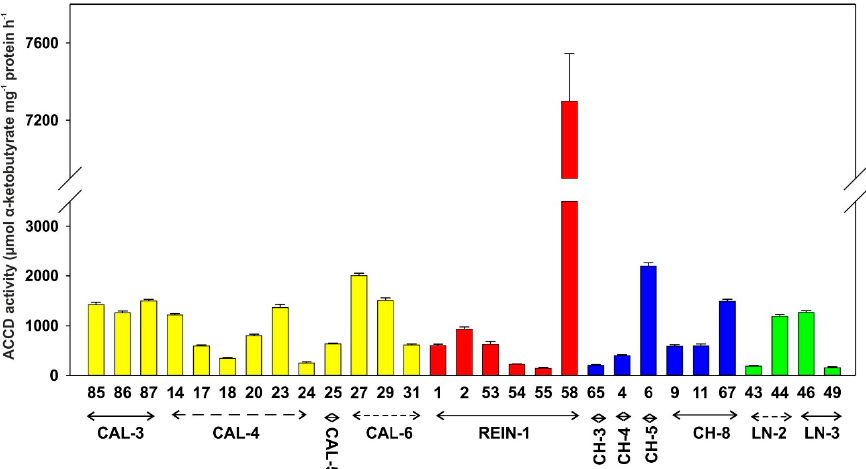
Figure 6. ACCD (1-aminocyclopropane-1-carboxylate deaminase) activity. For other